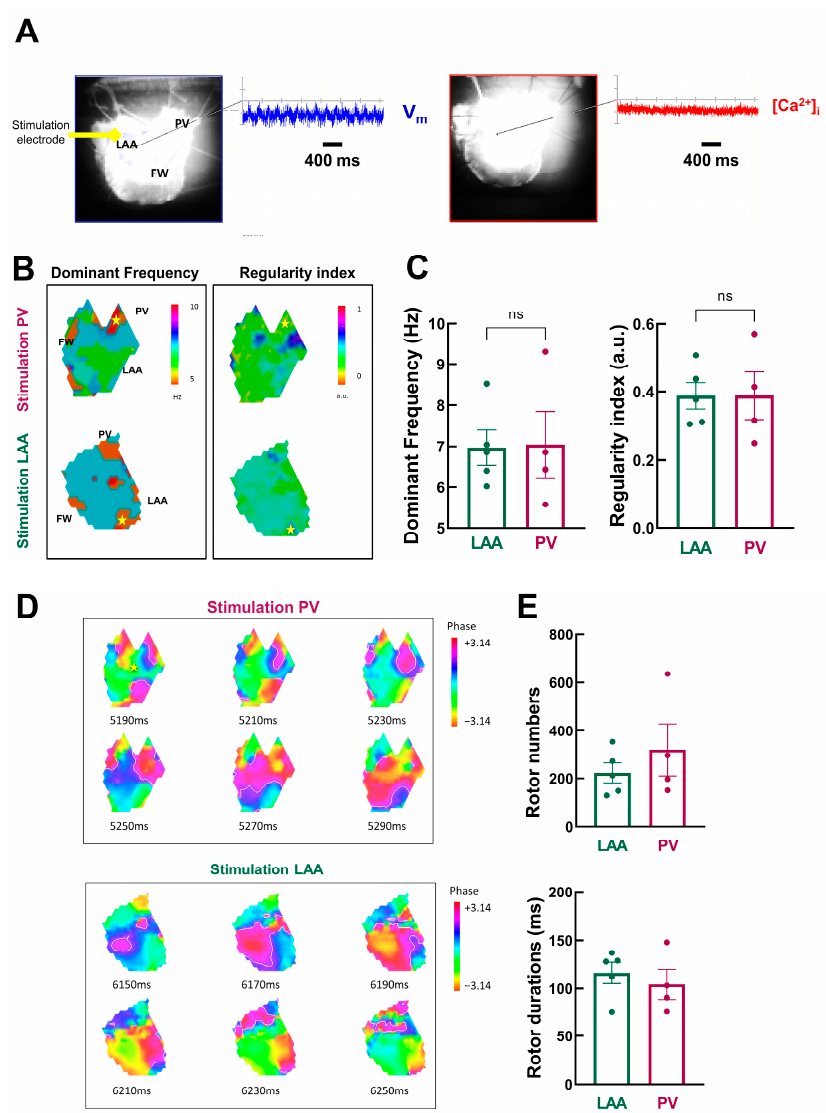
Figure 7. Detailed dynamic analysis of AF episodes ( A ) V m and [Ca 2+ ] i signals during acute AF episodes. ( B ) Example of dominant frequency (left) and regularity index (right) during AF triggered at PV (top) and LAA (bottom) sites. ( C ) Mean data for dominant frequency (left) and regularity index (right) at LAA (green) and PV (purple) sites. N = 4–5; unpaired t -test. ( D ) Phase mapping analysis of AF episodes (snapshot of phase values with 20 ms intervals for AF episodes triggered by PV (top) and LAA (bottom) pacing). ( E ) Mean data for rotor number (top) and duration (bottom). N = 4–5; unpaired t-test.